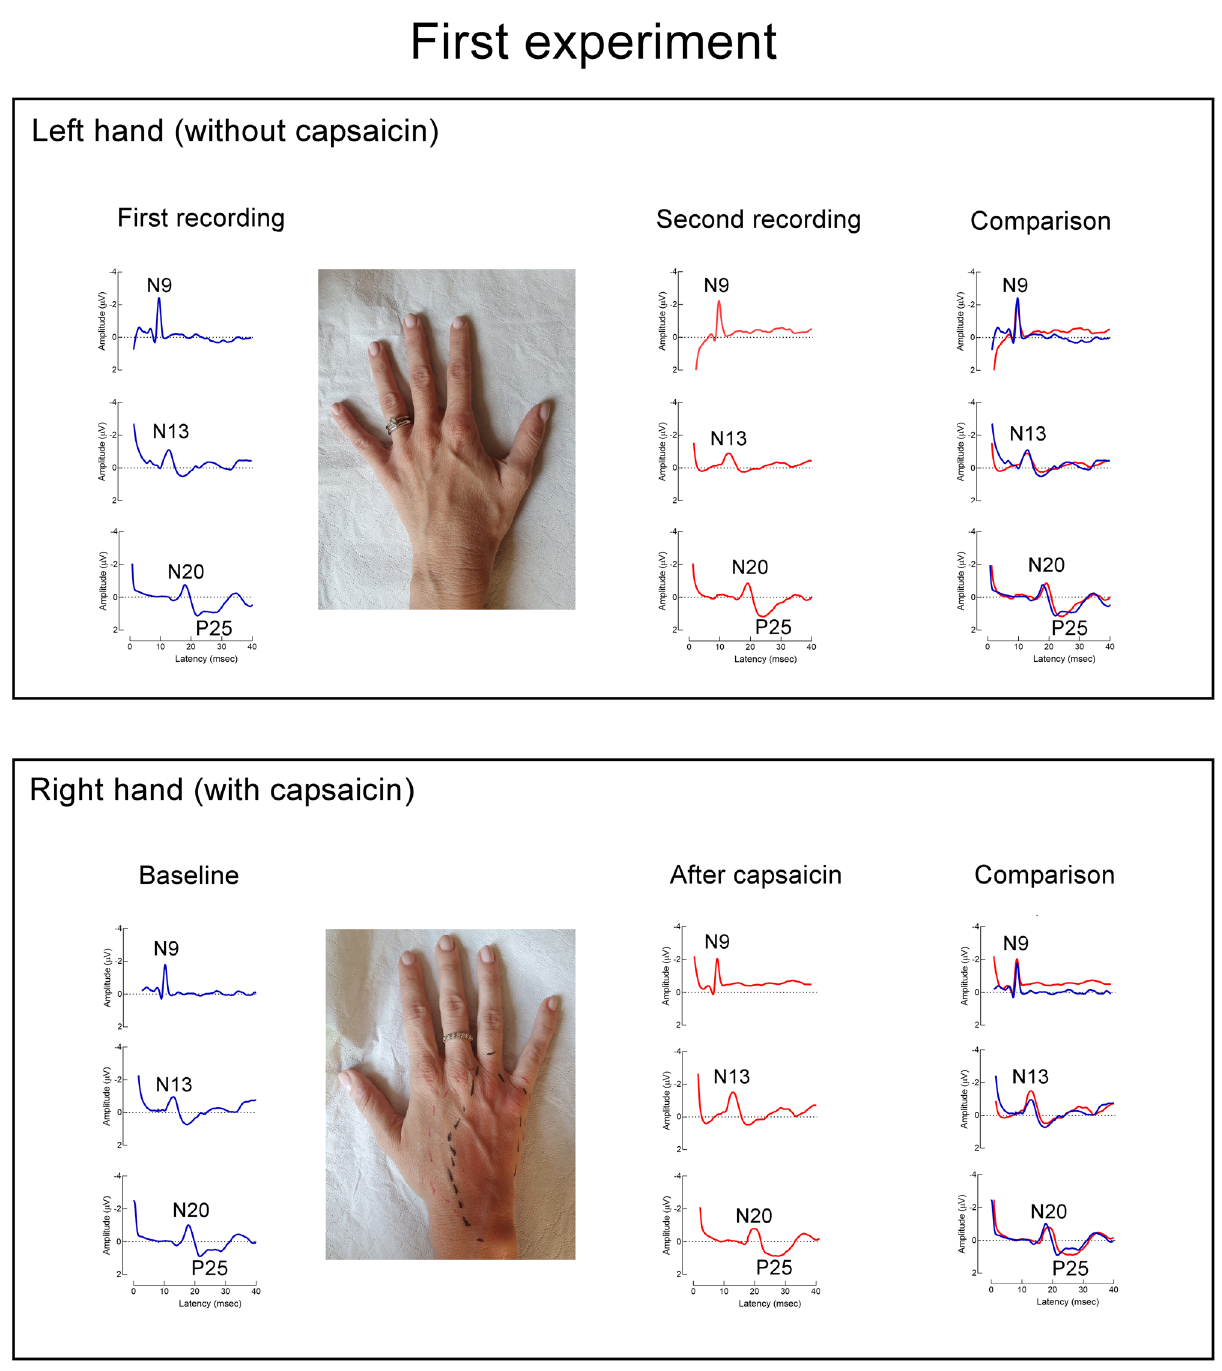
Figure 1. Experiment 1: Capsaicin-induced modulation of somatosensory evoked potentials (SEPs). Grand- average of SEP recordings. Topical capsaicin cream was applied on an area of about 15–18 cm 2 , covering almost the entire ulnar nerve territory of the hand dorsum in most subjects. This area corresponded to the area of primary hyperalgesia. N13 SEP amplitude increased after capsaicin application. The other SEP components (namely N9 and N20) did not change. The amplitude of SEP components after stimulation of the left hand did not change between the two recording